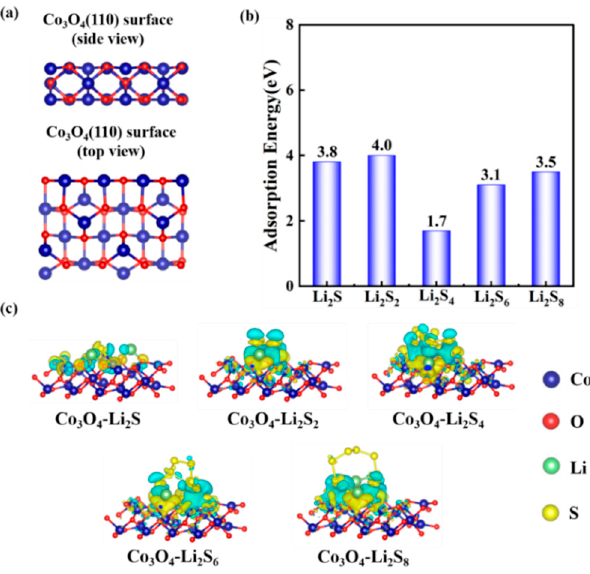
Figure 10. ( a ) Side and top views of the geometric configurations of Co 3 O 4 (110) surface. ( b ) Surface adsorption energies towards polysulfides. ( c ) Electron density differences of the polysulfides (Li 2 S, Li 2 S 2 , Li 2 S 4 , Li 2 S 6 , Li 2 S 8 ).